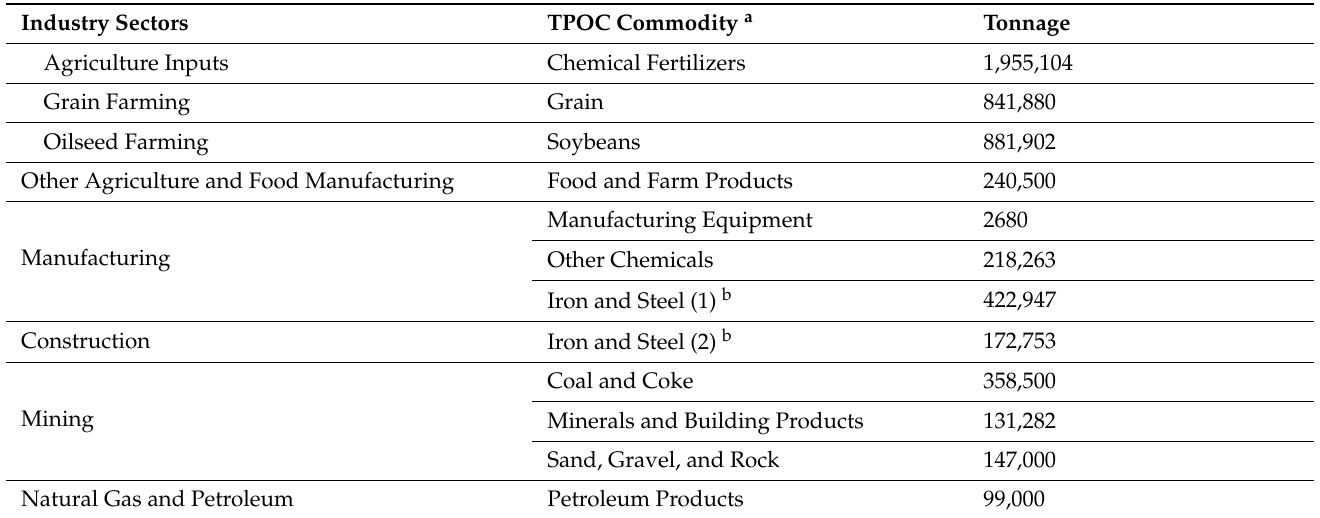
Table 2. Tonnage of Commodities Through TPOC in 2018 and Reclassification into